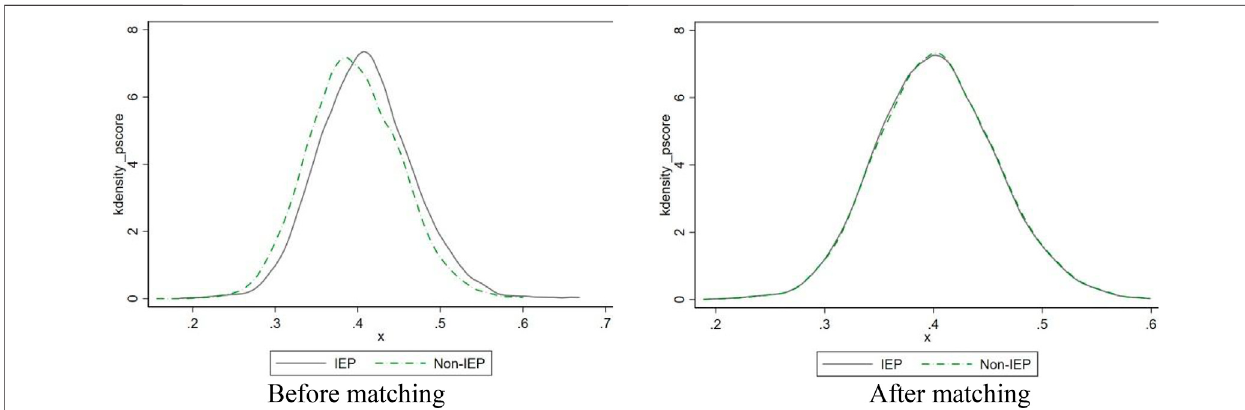
FIGURE 1 | Propensity score fi tting plot before and after PSM.